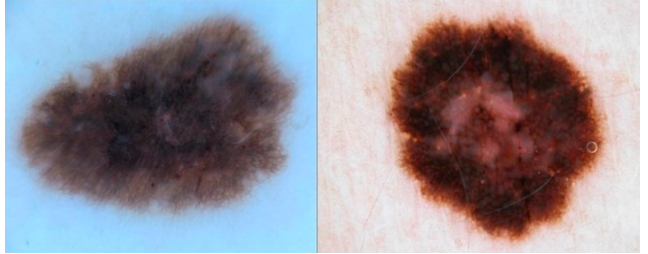
Figure 1. Examples of normal and abnormal images from the ISIC2017 dataset.